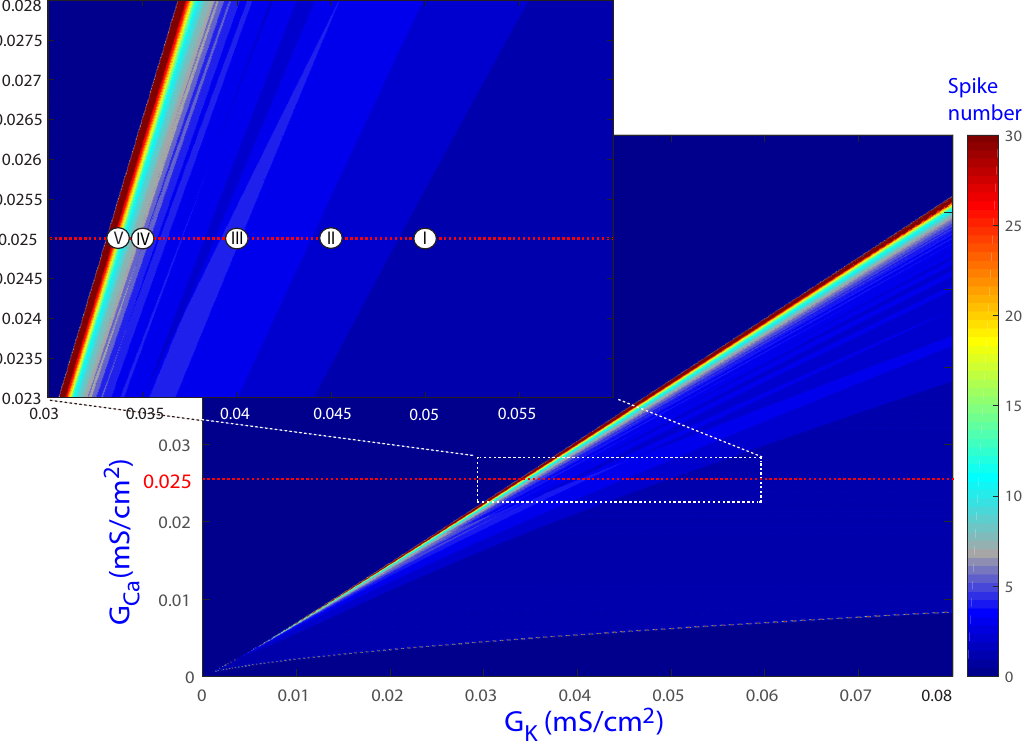
Figure 2. Regions of the spike-counting analysis for the biparametric plane ( G K , G Ca ). In the upper left inset, a magnification of a specific region is shown. Different colors mark different numbers of spikes in the attracting orbit. A triangular shape region delimits the regions of beats with and without EADs. Point I corresponds to a normal beat without EADs (illustrated in Figure 3b). In the region of Point II, the periodic orbit shows one EAD (illustrated in Figure 3d). More EADs are present when the parameters move to the lightest blue and red regions (illustrated in Figure 3f for Point III and in Figure 4c,f for Points IV and V, respectively). The horizontal red dashed line corresponds to the default value G Ca =